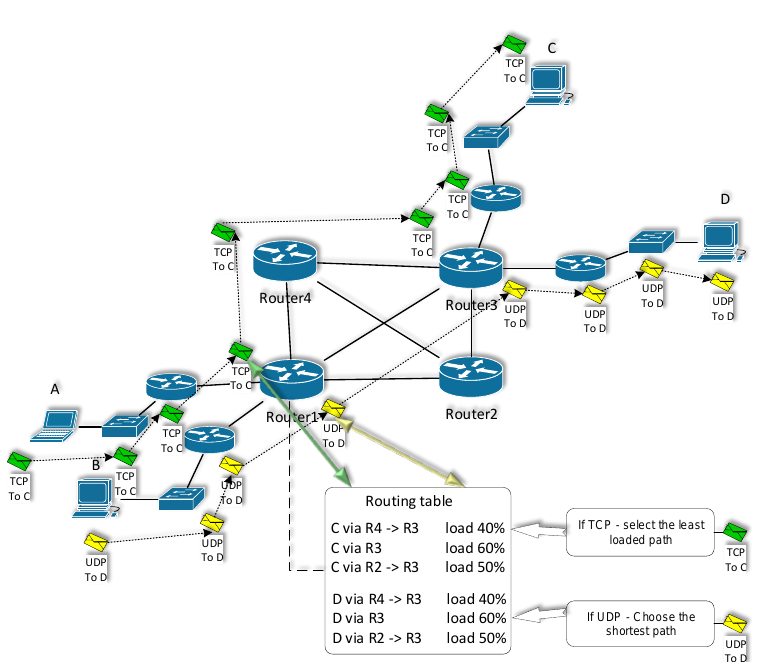
Figure 15. Packet routing decision-making according to the used transport protocol.